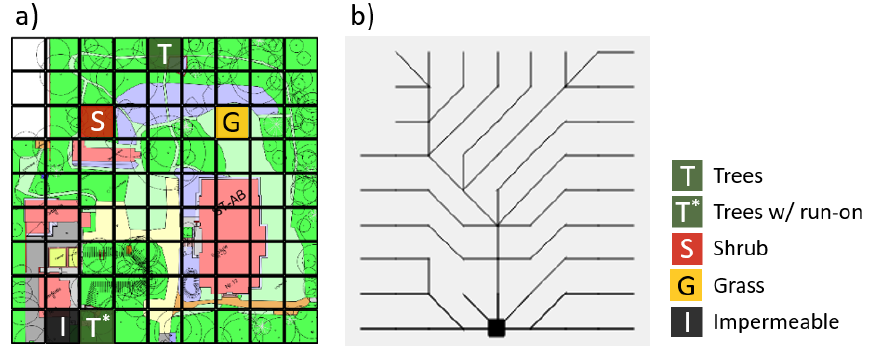
Figure 3. Model domain for SUEO (a) Model grid with impermeable (black), trees (with and without run-on, green), shrub (red) and grassland (yellow) cells marked. (b) Local drainage network with the outlet in the lower middle cell. Data source base map (a) TU Berlin